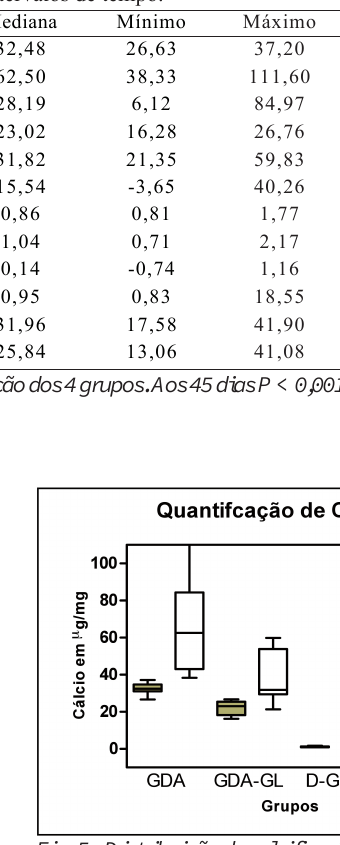
Fig. 5 - Distribuição de calcificação por grupos nos intervalos de tempoFig. 4. - Gráfico com os percentis de áreas calcificadas nos grupos